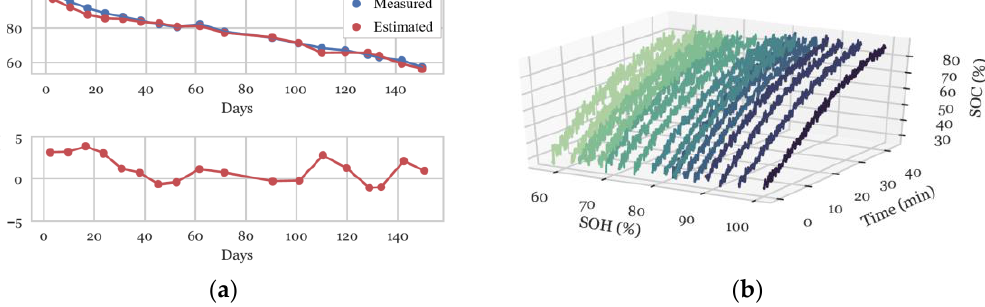
Figure 7. ( a ) CNN SOH estimation and error for partial charge curve input beginning at 30% SOC and ending at about 85% SOC. ( b ) Partial charge profiles beginning at 30% SOC and ending at about 85% SOC.